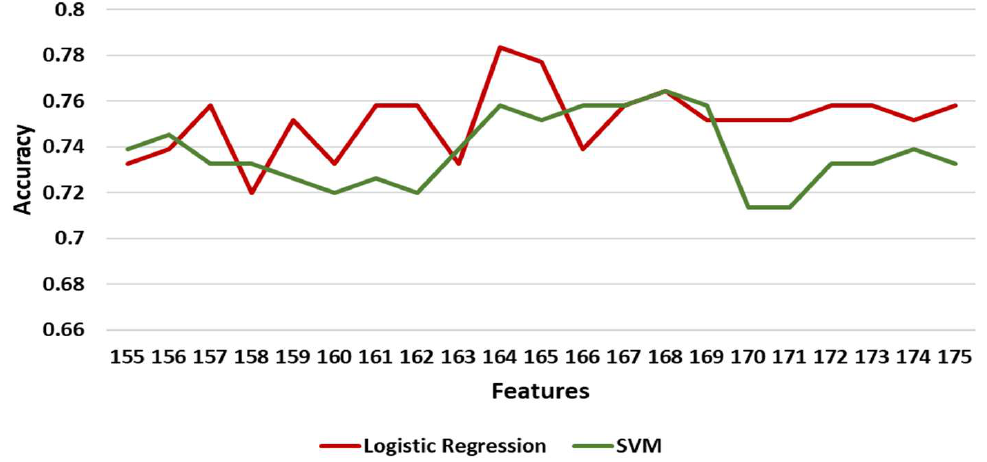
Figure 6. The accuracy of LR (logistic regression) and SVM at [155, 175] features over the test set for left leg. Results are shown with a step size of 1 (one feature added at each step).